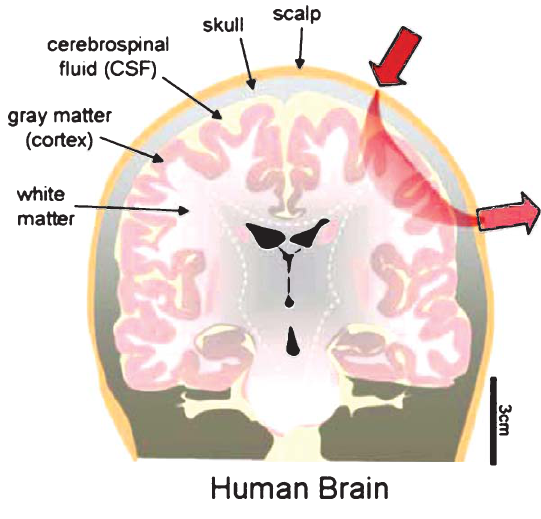
Fig. 3. Human brain and placement of optodes (after